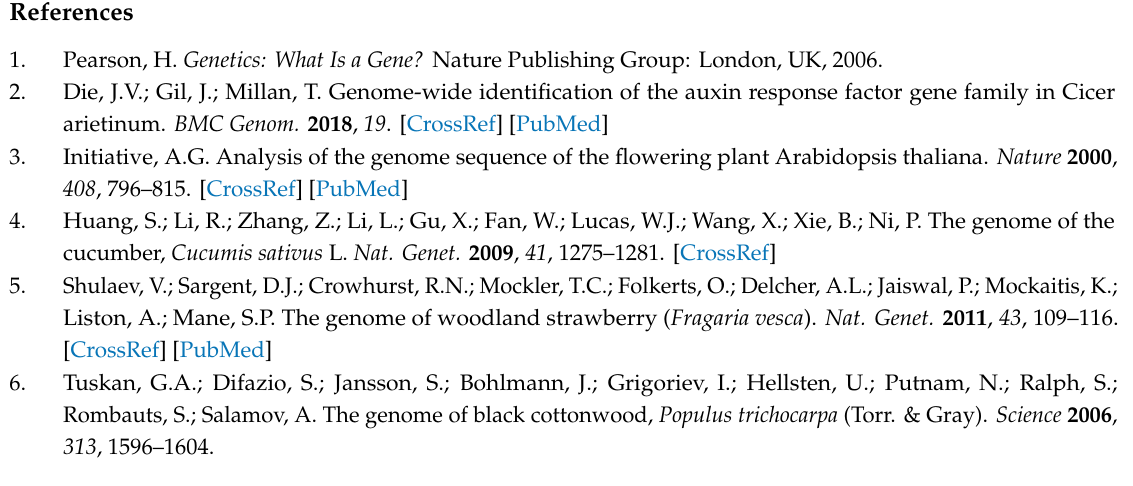
Figure S1: Exon-intron structures of BpNACs . The genomic structure information of the BpNACs was obtained from CoGe (https: // genomevolution.org / coge / ). Figure S2: Conserved amino acid motifs of the BpNAC proteins. Figure S3: Chromosomal distribution of BpNAC genes in B. pendula . Figure S4: Chromosomal distribution and gene duplications of the BpNAC genes. Figure S5: The phylogenetic tree of BpNACs made by RAxML. Its confidence was evaluated with 1000 bootstraps. Table S1: Primer pairs for real-time quantitative PCR. Table S2: Basic information of the putative truncated BpNACs without the NAC domain. Table S3: Functional annotation of the BpNAC gene family. Table S4: Promoter identification of the BpNAC gene family. Table S5: Summary of B. pendula RNA-Seq data. Table S6: Tissue-specific expression profiles of the BpNAC gene family. Table S7: Di ff erential expression profiles of the BpNAC gene family under cold